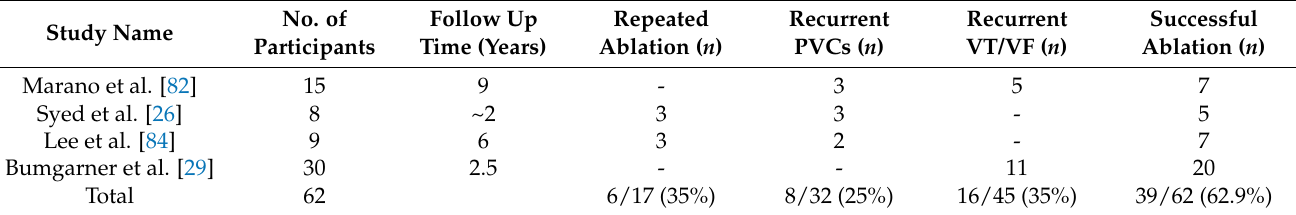
Table 2. Outcomes of catheter ablation of ventricular arrythmia in